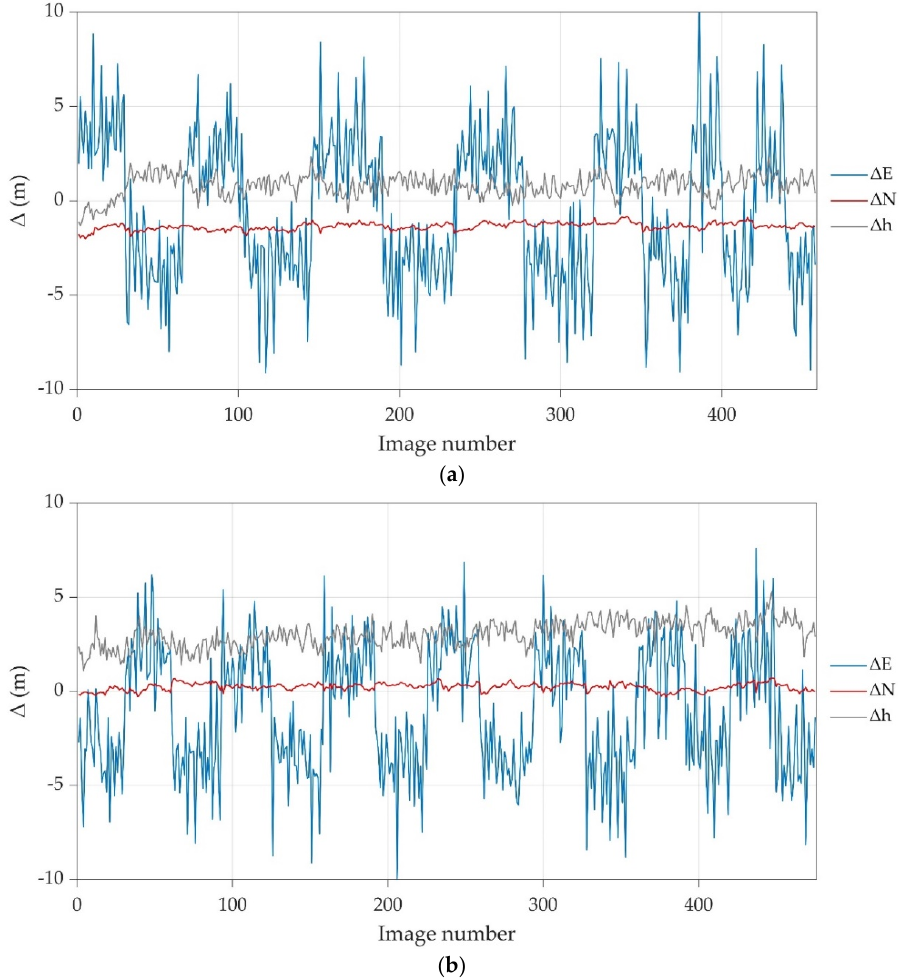
Figure 3. Differences (∆) between the single-frequency and dual-frequency exposure (camera) Figure 3. Di ff erences ( ∆ ) between the single-frequency and dual-frequency exposure (camera) position position estimates for: (a) the first flight, and (b) the second flight (∆E - easting, ∆N - northing, ∆h - estimates for: ( a ) the first flight, and ( b ) the second flight ( ∆ E—easting, ∆ N—northing, ∆ h—altitude). altitude). Differences (∆) are expressed in HTRS96/TM (ESPG: 3765). Di ff erences ( ∆ ) are expressed in HTRS96 / TM (ESPG: Table 3. Basic statistics of differences between the single-frequency and dual-frequency exposure (camera) position estimates for the first and second flights (E - easting, N - northing, h - altitude).